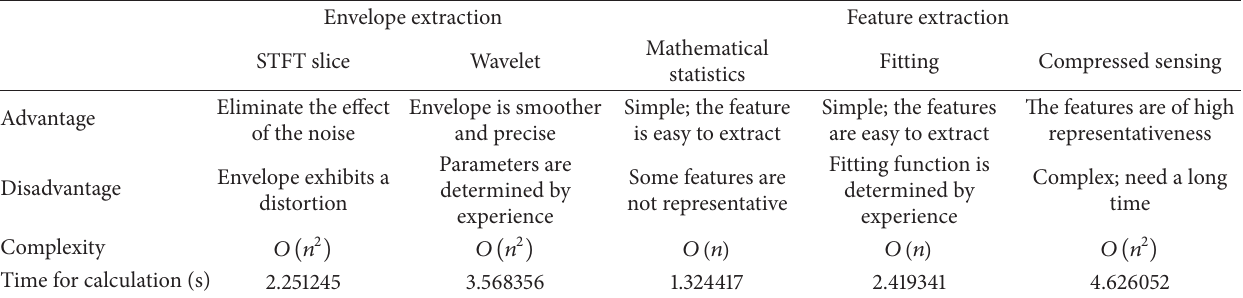
Table 3: Performance comparison for the envelope extraction and feature extraction.